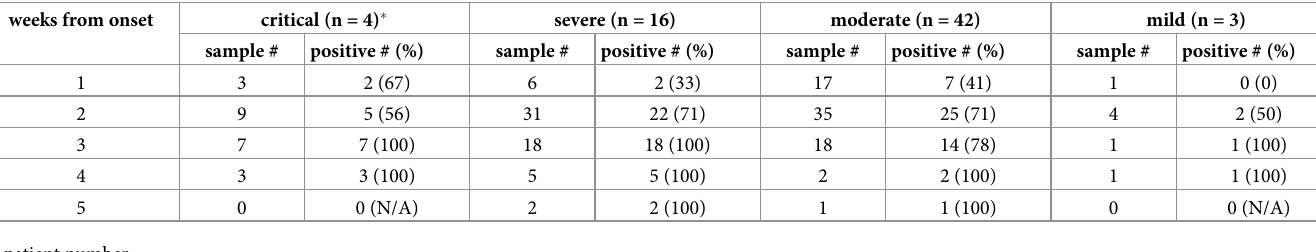
Table 4. Clinical sensitivity of cPass